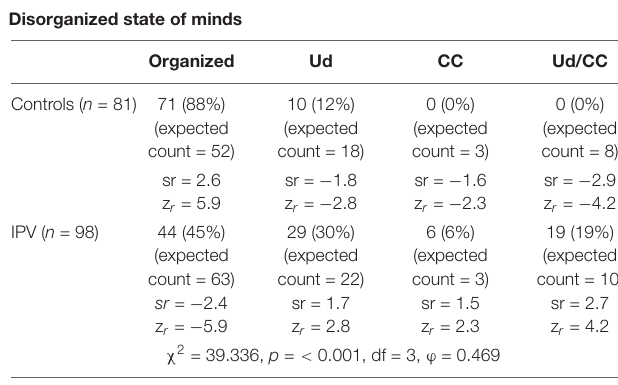
TABLE 3 | AAI classifications (secure vs. insecure) in the IPV and control group.